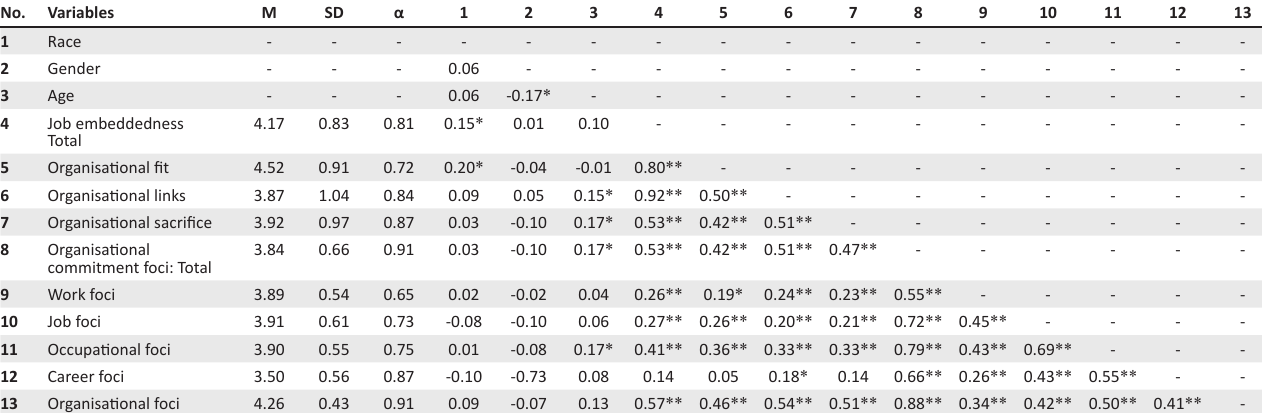
TABLE 1: Descriptive statistics, zero-order correlations and internal consistency reliability. No. Variables